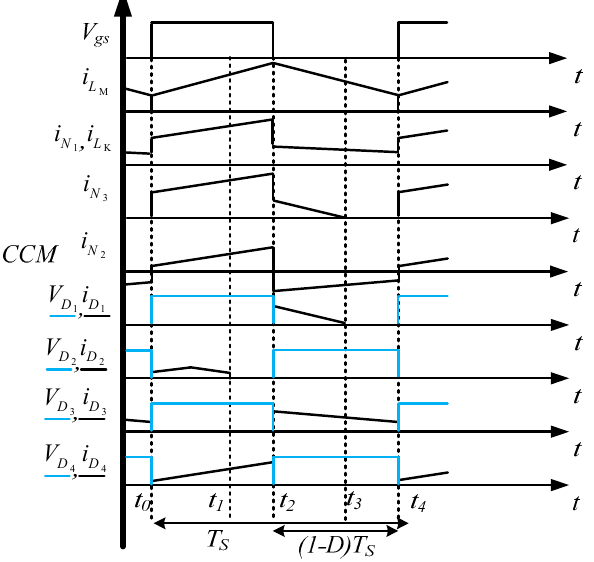
Figure 2. Some typical waveforms of proposed converter at continuous conduction mode (CCM) operation. (4) Mode IV [ t 3 , t 4 ]: during this time interval, the switch S is still turned off. The current-flow path is shown in Figure 3d.The input source connects in series with the primary-side winding N 1 , the secondary-side winding N 2 of the coupled inductor, the capacitor C 2 and the capacitor C 4 to provide energy for the load through D 3 . This mode ends at t = t 4 when the switch S is turned on at the beginning of the next switching period.